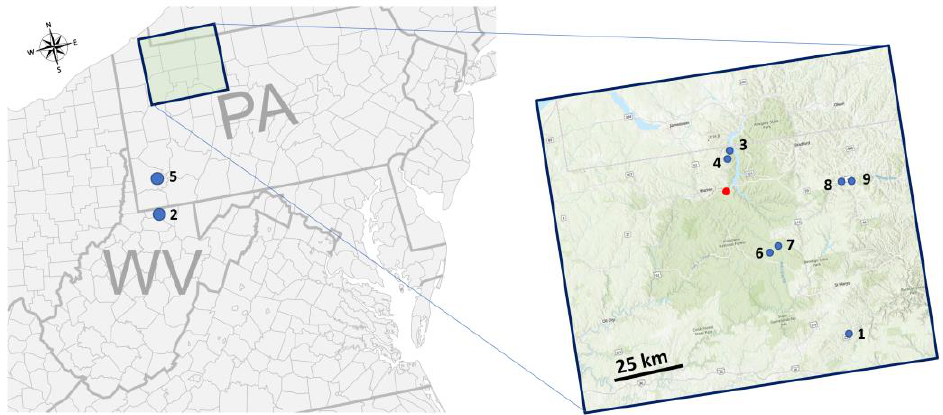
Figure 6. Locations of study sites (blue and red dots) in Pennsylvania and West Virginia, USA. The red dot indicates the site where data for deep learning were collected, and the blue dots indicate in-situ validation study sites.